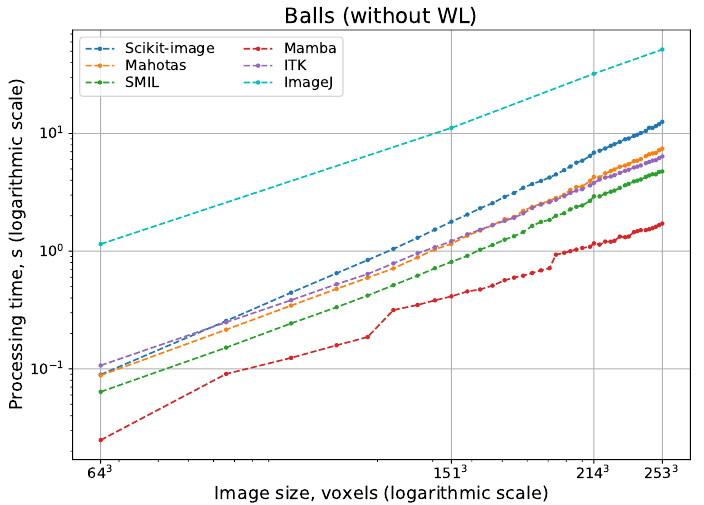
Figure 11. Processing time for watershed with WL depending on 3D image size.